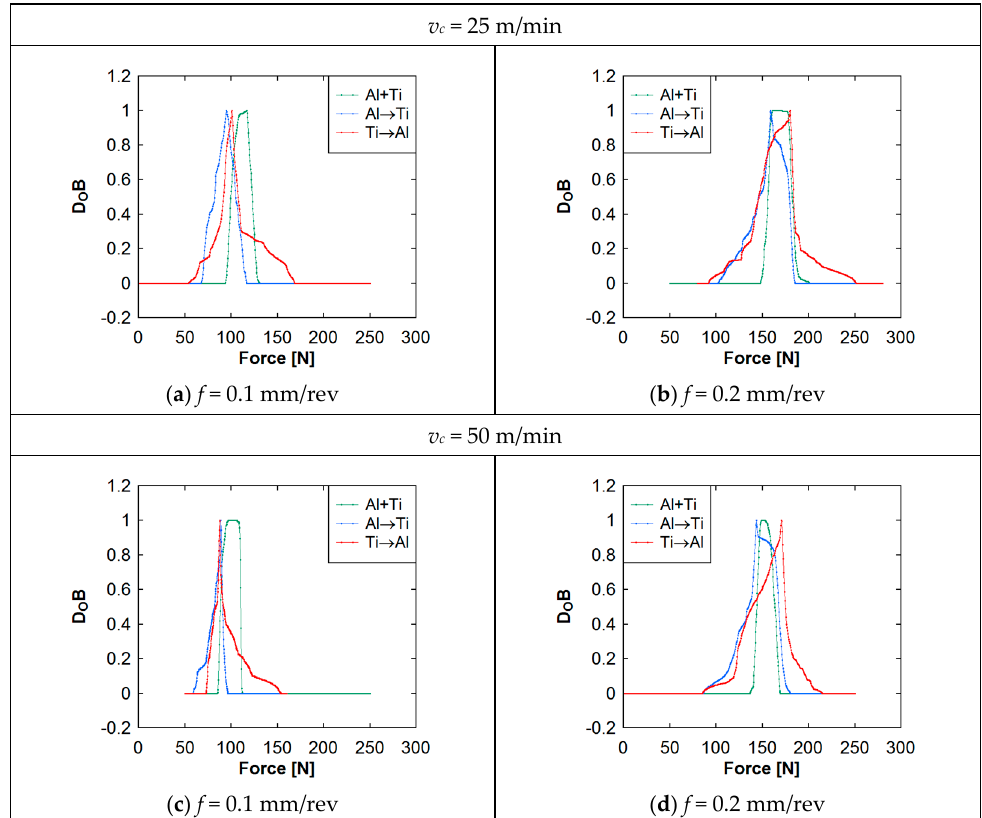
Figure 7. Uncertainties in the machining forces underlying Al − Ti.